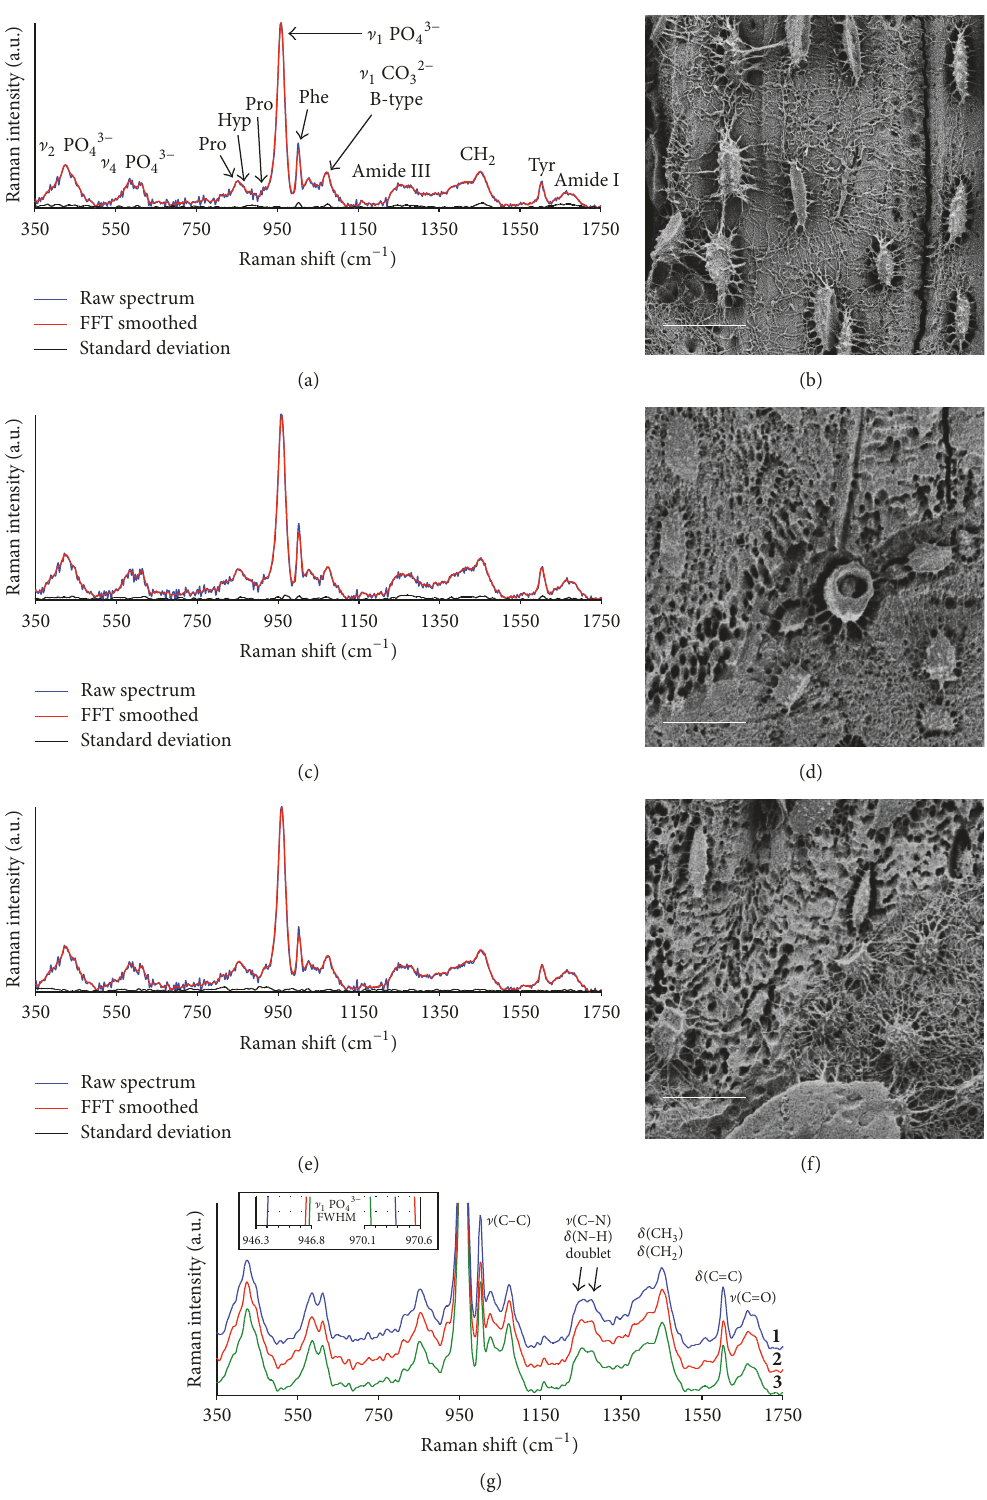
Figure 4: Raman spectra of the (a) native bone and the interfacial tissue 5–10 𝜇 m from the (c) Ep and (e) Ep+An implant surfaces. (b) Osteocytes in the native bone are aligned parallel to the lamellar direction. The interface between the bone tissue contained within the (d) Ep and (f) Ep+An implant threads and the native bone outside the implant threads. Scale bars = 20 𝜇 m. (g) Raman spectra ( y -axis shifted) for the three groups: bone, anodised, and electropolished. Inset in (g): Raman spectra (overlaid/not y -axis shifted, x -axis truncated) showing the half-maximumregionof ] 1 PO 43− at960 cm −1